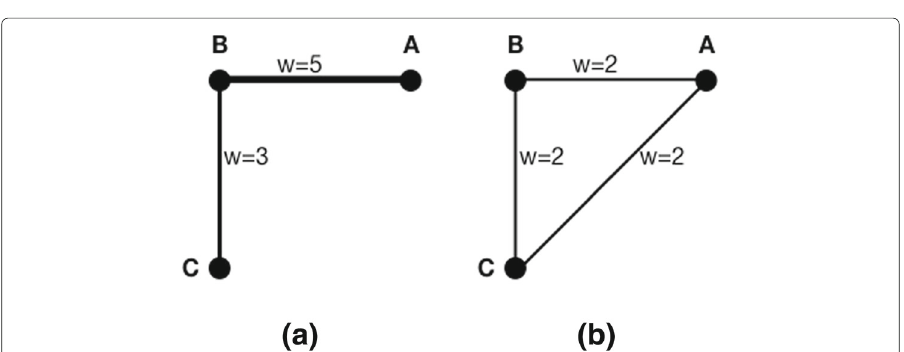
Fig. 1 Two networks with three nodes and weighted edges. The width of the edges corresponds to their weights. The panels present two different interaction patterns and edge